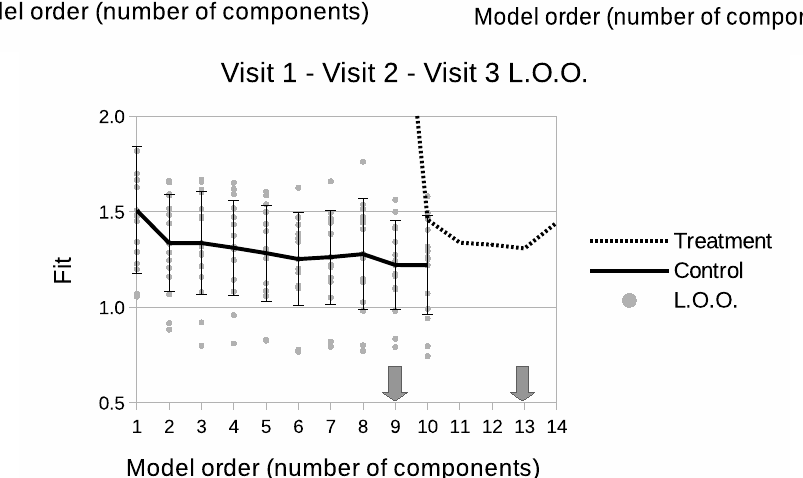
Figure 3. Leave-One-Out model selection summary showing goodness-of-fit (square-root of χ 2 per degree of freedom) as a function of number of model components. Solid lines show model fits for control data only. Dotted lines show fits as treatment data is introduced to the model. Grey dots show individual fits for control LOO samples. ‘v’s indicate time points included in the model.